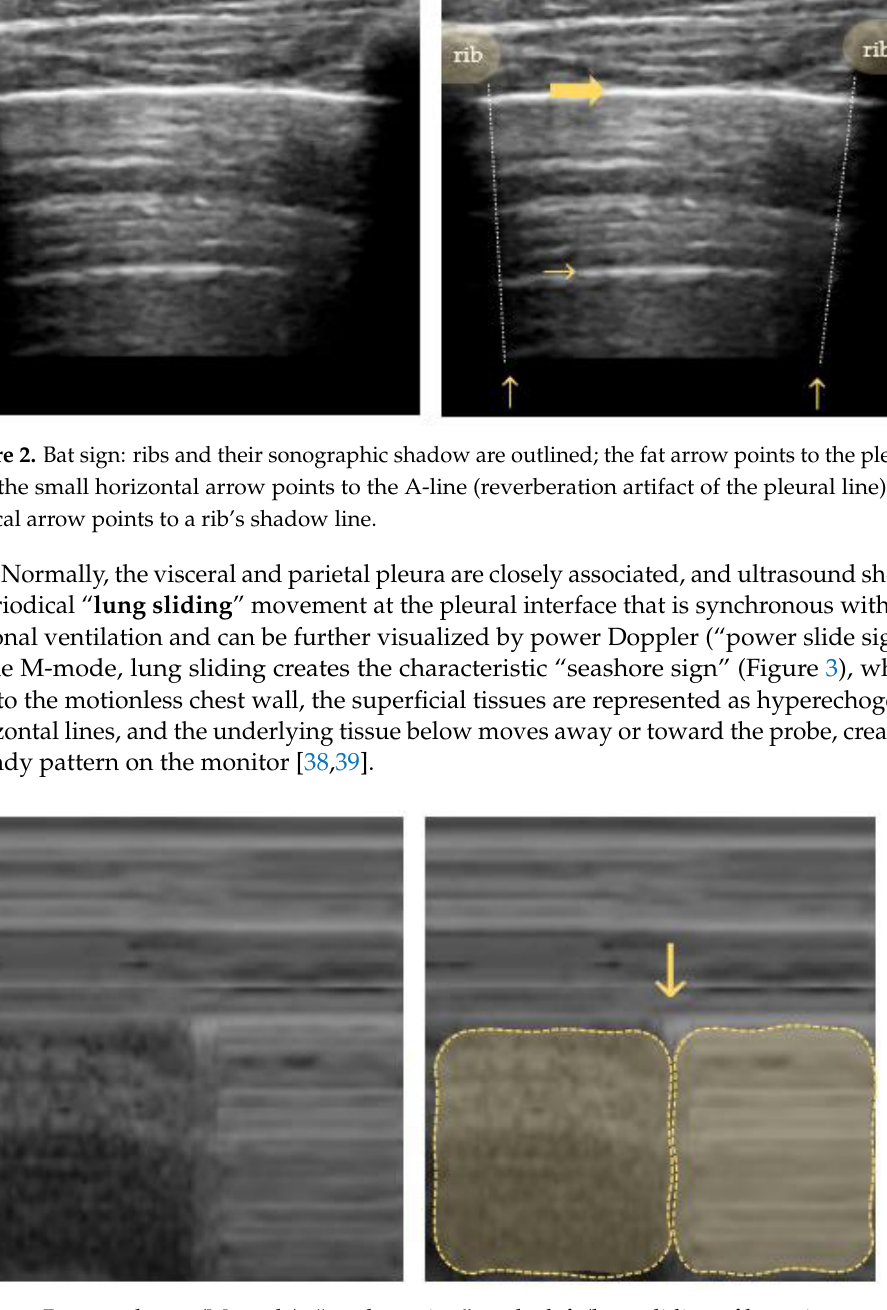
Figure 3. Pneumothorax (M-mode): “seashore sign” on the left (lung sliding of lung tissue creates a sand-like pattern) and “stratosphere sign” on the right (parallel lines created by abolished lung sliding); the vertical arrow points to the lung point in between.